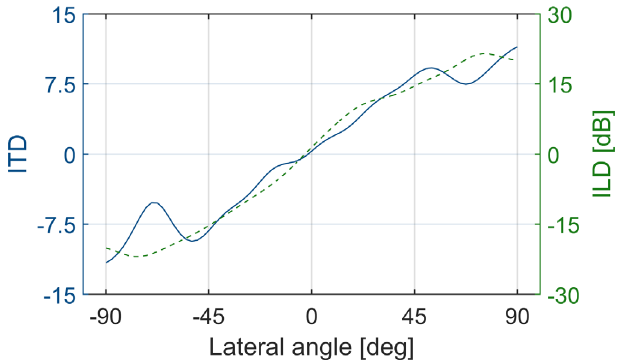
Figure 2. Interaural features as functions of lateral angle in the horizontal frontal plane. Left axis (blue solid line): Transformed ITD x itd (dimensionless), see equation (2). Right axis (green dashed line): ILD (in dB) obtained from the magnitude pro fi les. Example for subject NH12